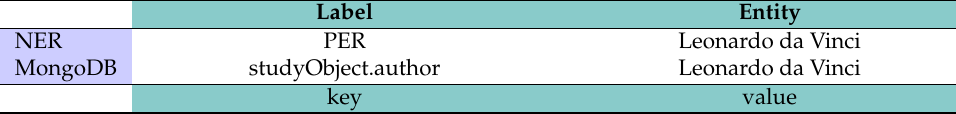
Table 5. Example of a match between the annotated entity and the relative MongoDB query.